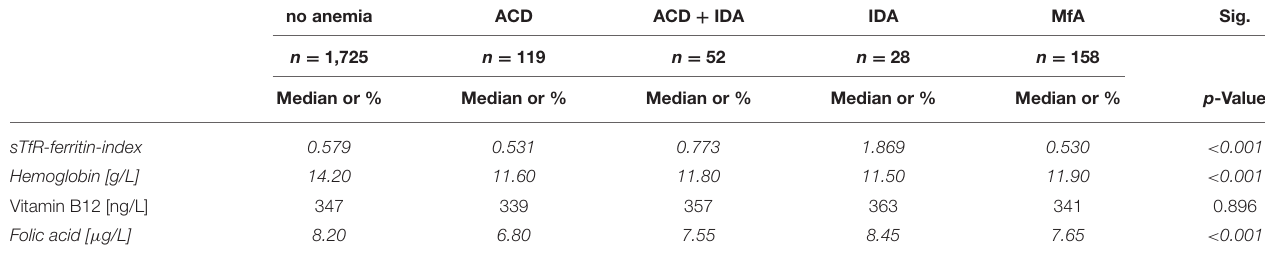
Frontiers in Cardiovascular Medicine |